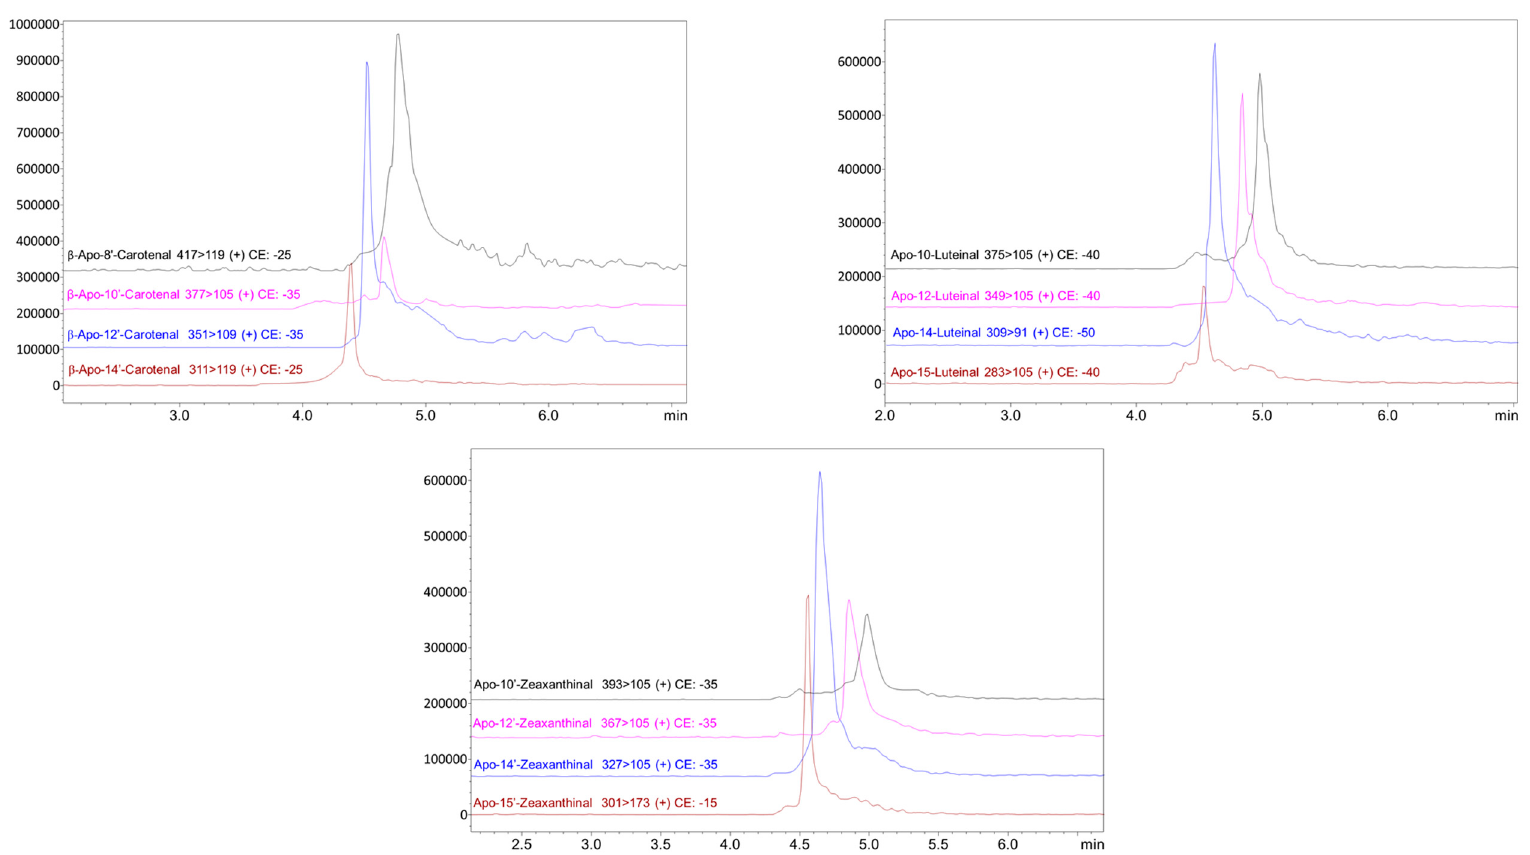
Figure 3. MRM analysis enlargements (transitions in APCI positive) relative to the detected β -apo-carotenals, apo-zeaxanthinals, and ε -apo-luteinals in the different microalgae strains.